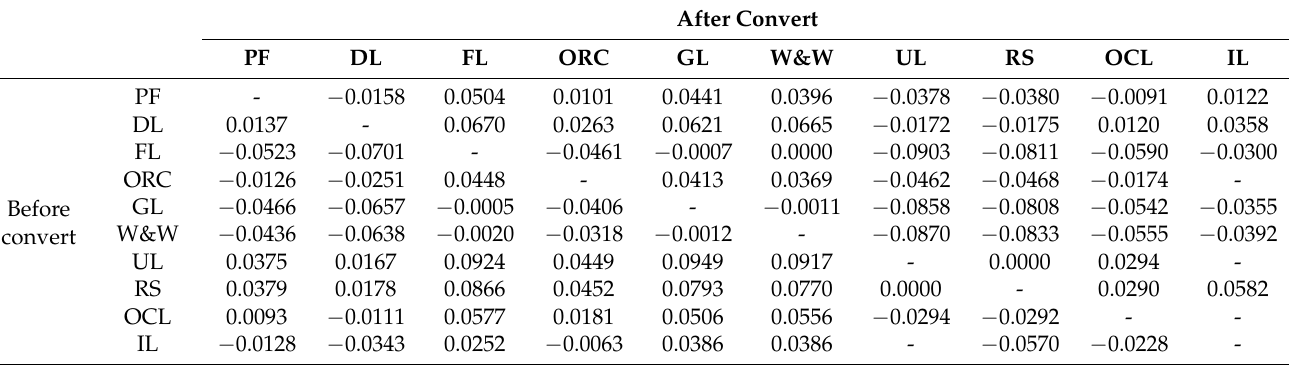
quality, with IDIs of less than − 0.05. Table 3. The IDIs of different land use change types.